Question: Express in one sentence what the figure is showing.
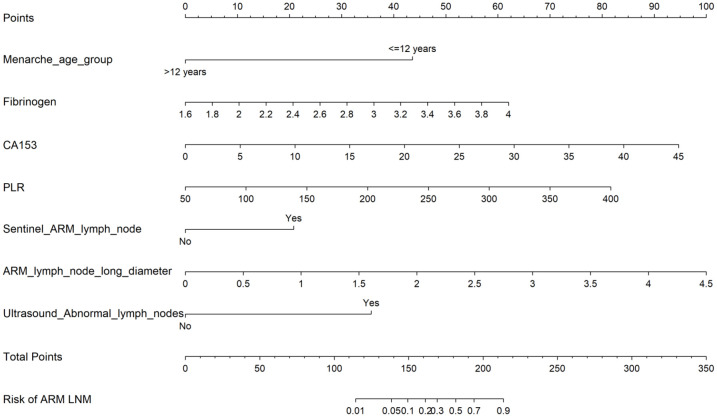
Answer: Nomogram for risk of ARM lymph node metastasis in patients with breast cancer. We used the “rms” package in R to construct a nomogram based on seven variables screened using univariable and multivariable logistic regression analyses. Each variable corresponds to a score on the top point axis. Add up the scores of each variable to obtain the total score. Project the total score onto the risk/probability axis to estimate the probability of ARM lymph node metastasis. CA15-3, cancer antigen 15-3; PLR, platelet-to-lymphocyte ratio; ARM, axillary reverse mapping.